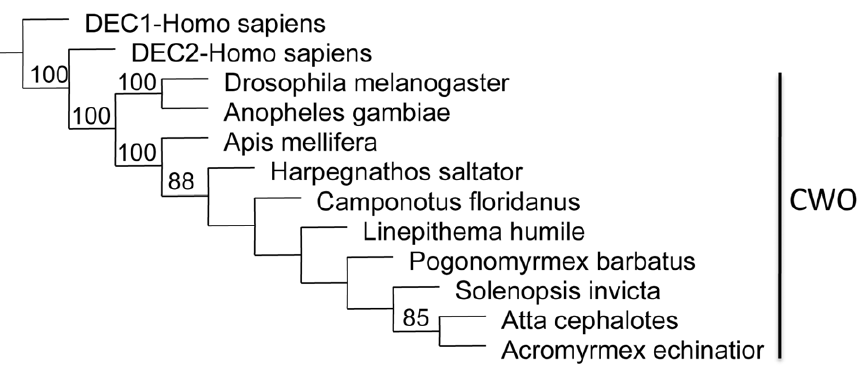
Figure 2. Parsimony tree for clockworkorange orthologs. Shown is a consensus tree with bootstrap values from 250 replicates. Insect CWO orthologs clearly separate from mammalian orthologs Dec1 & Dec2 .